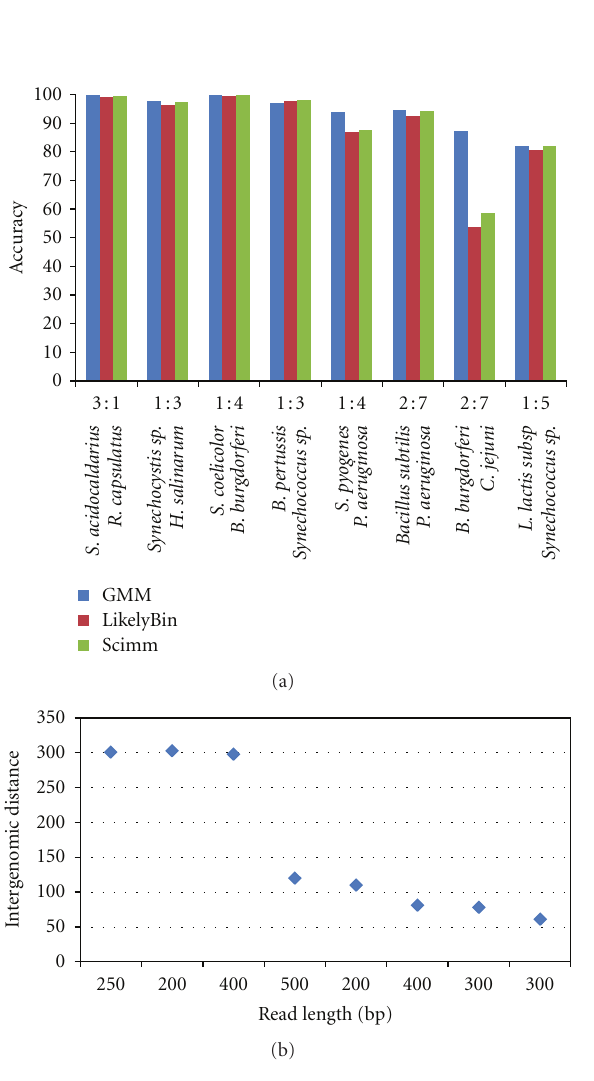
Figure 4: GMM stands for Gaussian mixture model (without word grouping). (a) compares the performance of the three methods on 8 datasets ( X -axis shows the abundance ratio and the species con- tained in the dataset). (b) plots the δ ∗ values for the corresponding datasets. The X -axis shows the corresponding read lengths. Here, the δ ∗ (measured on 50 kb contigs) ranges from 34 to 340.